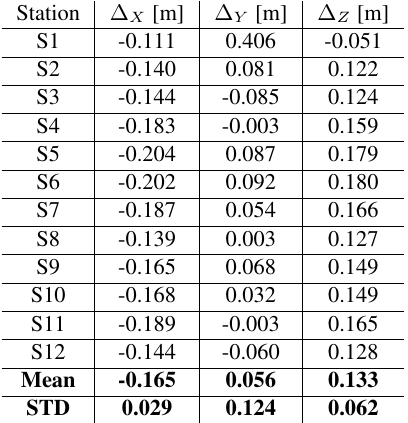
Table 4. Averages of residuals for each station using the processing that involves the AHRS